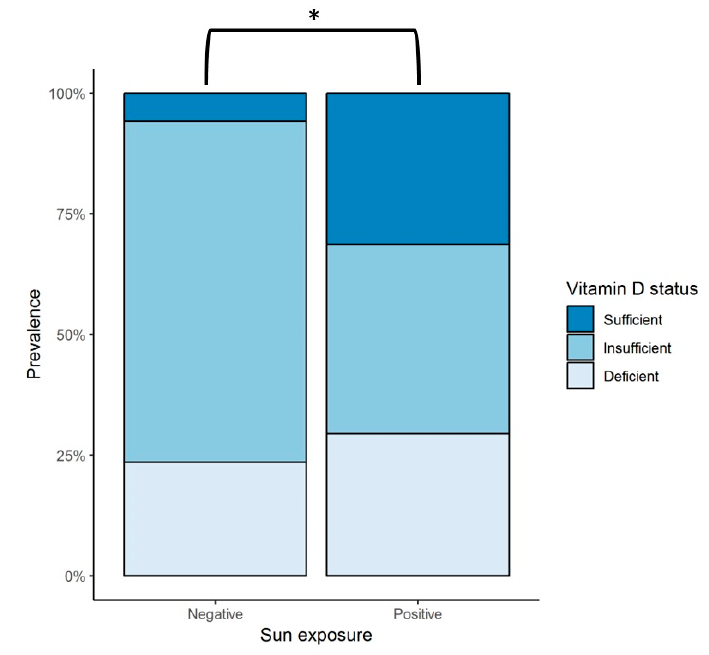
Figure 1. Sun exposure and vitamin D status in patients with heart failure during the 12-month follow up. Negative = observations with null sun exposure; positive = observations with any amount of sun exposure; * represents a statistically significant difference in the prevalence of vitamin D sufficiency in patients with some amount of sun exposure (positive), 31.4%, versus those with null exposure (negative), 5.9% ( p < 0.044). Sufficient vitamin D status is defined as serum 25(OH)D levels > 30 ng/mL, insufficient as serum 25(OH)D levels > 20 and < 30 ng/mL, and deficient status as serum 25(OH)D levels < 20 ng/mL. [30]. 25(OH)D = 25-hydroxyvitamin D.